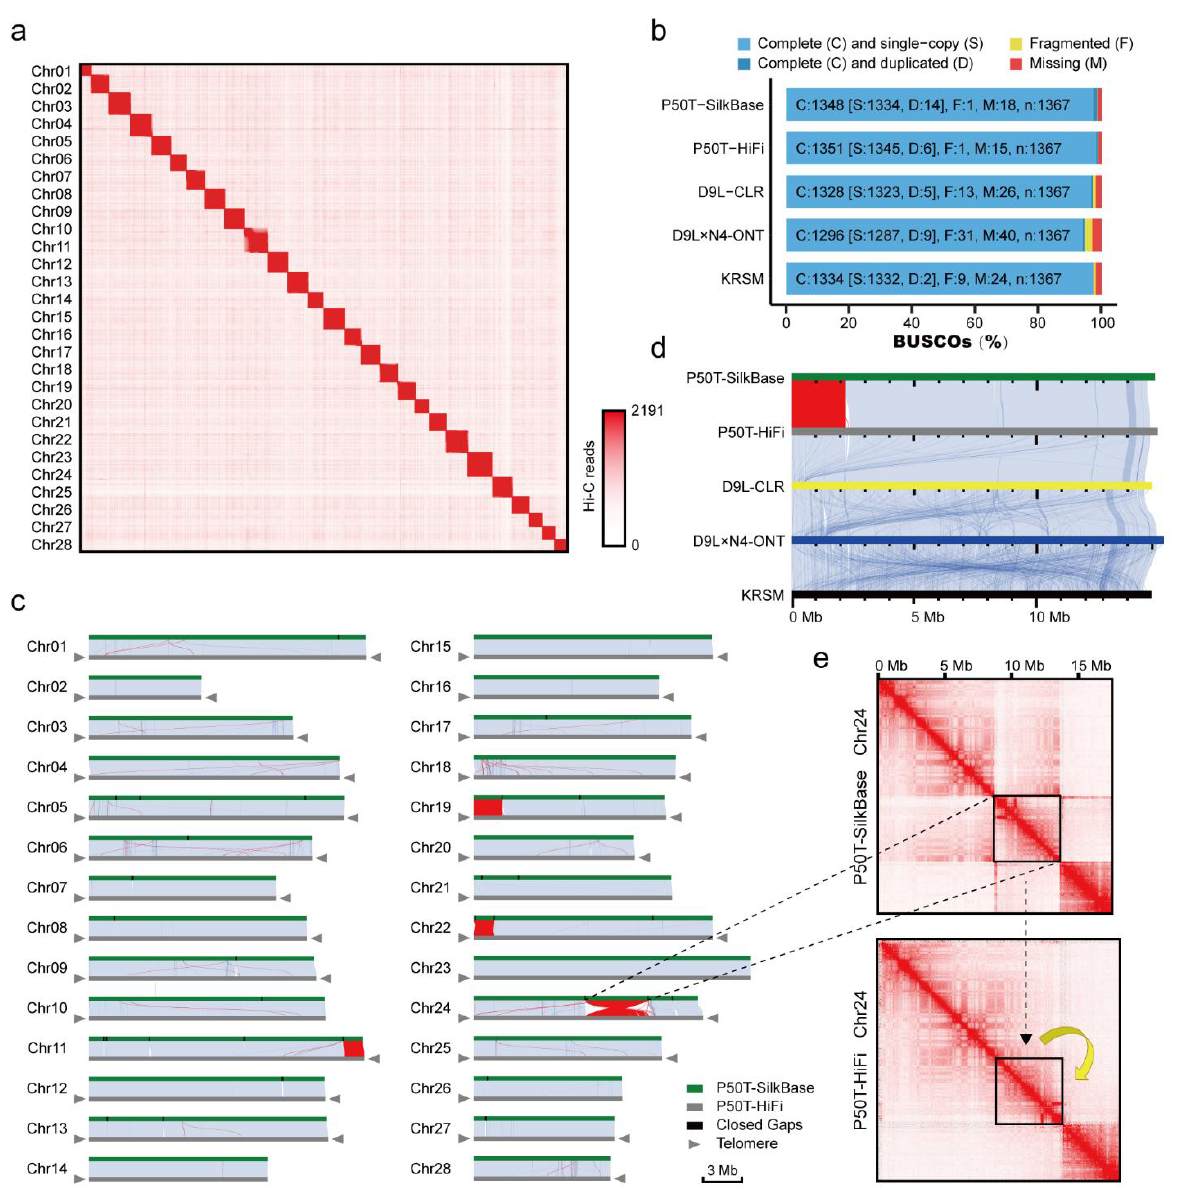
Figure 6. Summary of different silkworm strains chromosome-level genome assembly. ( a ) Hi-C genome-wide interaction map of the silkworm (P50T-HiFi) assembly. ( b ) BUSCO analysis of chromosome-level genome assemblies using the insect odb10 (1367 genes). ( c ) Collinearity between the silkworm P50T-SilkBase and P50T-HiFi genomes. The synteny blocks are shown by light blue lines. The inversions are indicated by red lines. The telomere sequence repeats are marked by gray triangles. All the P50T-SilkBase gap regions closed in P50T-HiFi are shown as black blocks. The gray triangles indicate the presence of telomere sequence repeats. ( d ) Collinearity of the P50T-SilkBase, P50T-HiFi, D9L-CLR, D9L × N4-ONT and Korean silkworm (KRSM) Chromosome 19. Synteny blocks are shown by light blue lines. The inversions are indicated by red lines. ( e ) Hi-C interaction map of silkworm chromosome 24. The black boxed area indicates the error inversion in P50T-SilkBase.